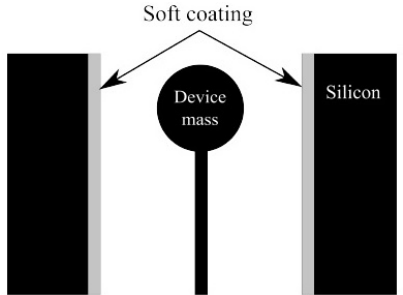
Figure 16. Soft thin-film coatings armour the colliding areas of a MEMS device, the number of collisions as well as the post shock settling time is reduced.